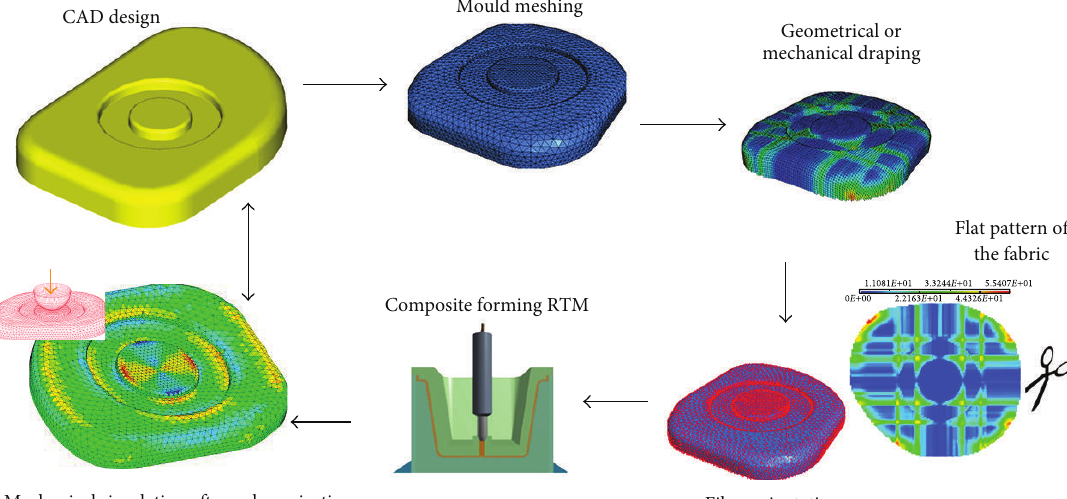
F 1: Illustration of the manufacturing of a textile reinforced composite